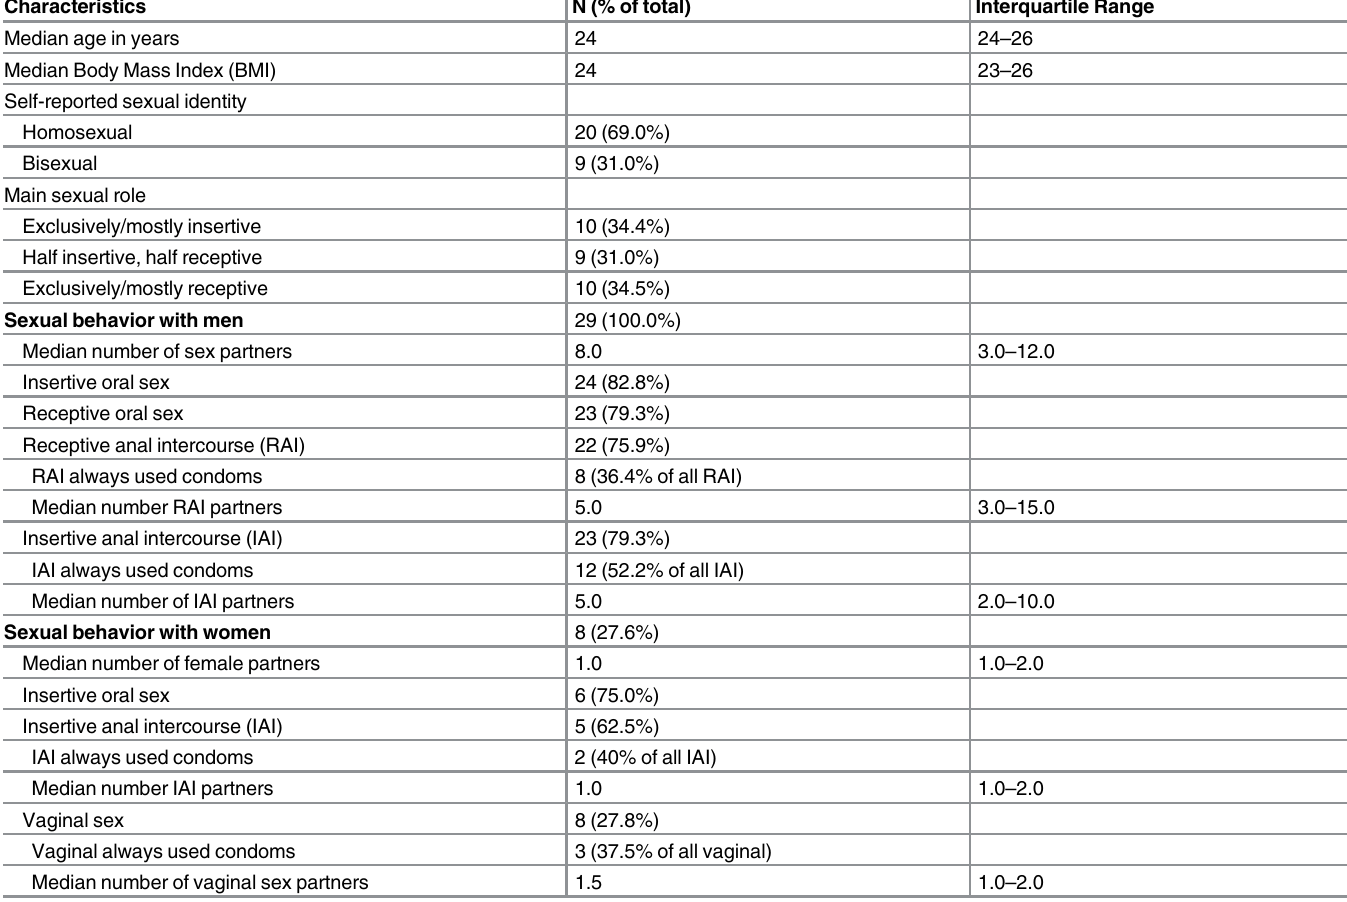
Table 1. Self-reported Demographic and Sexual Behavior of Study Participants During the Six Months Prior to Screening. *